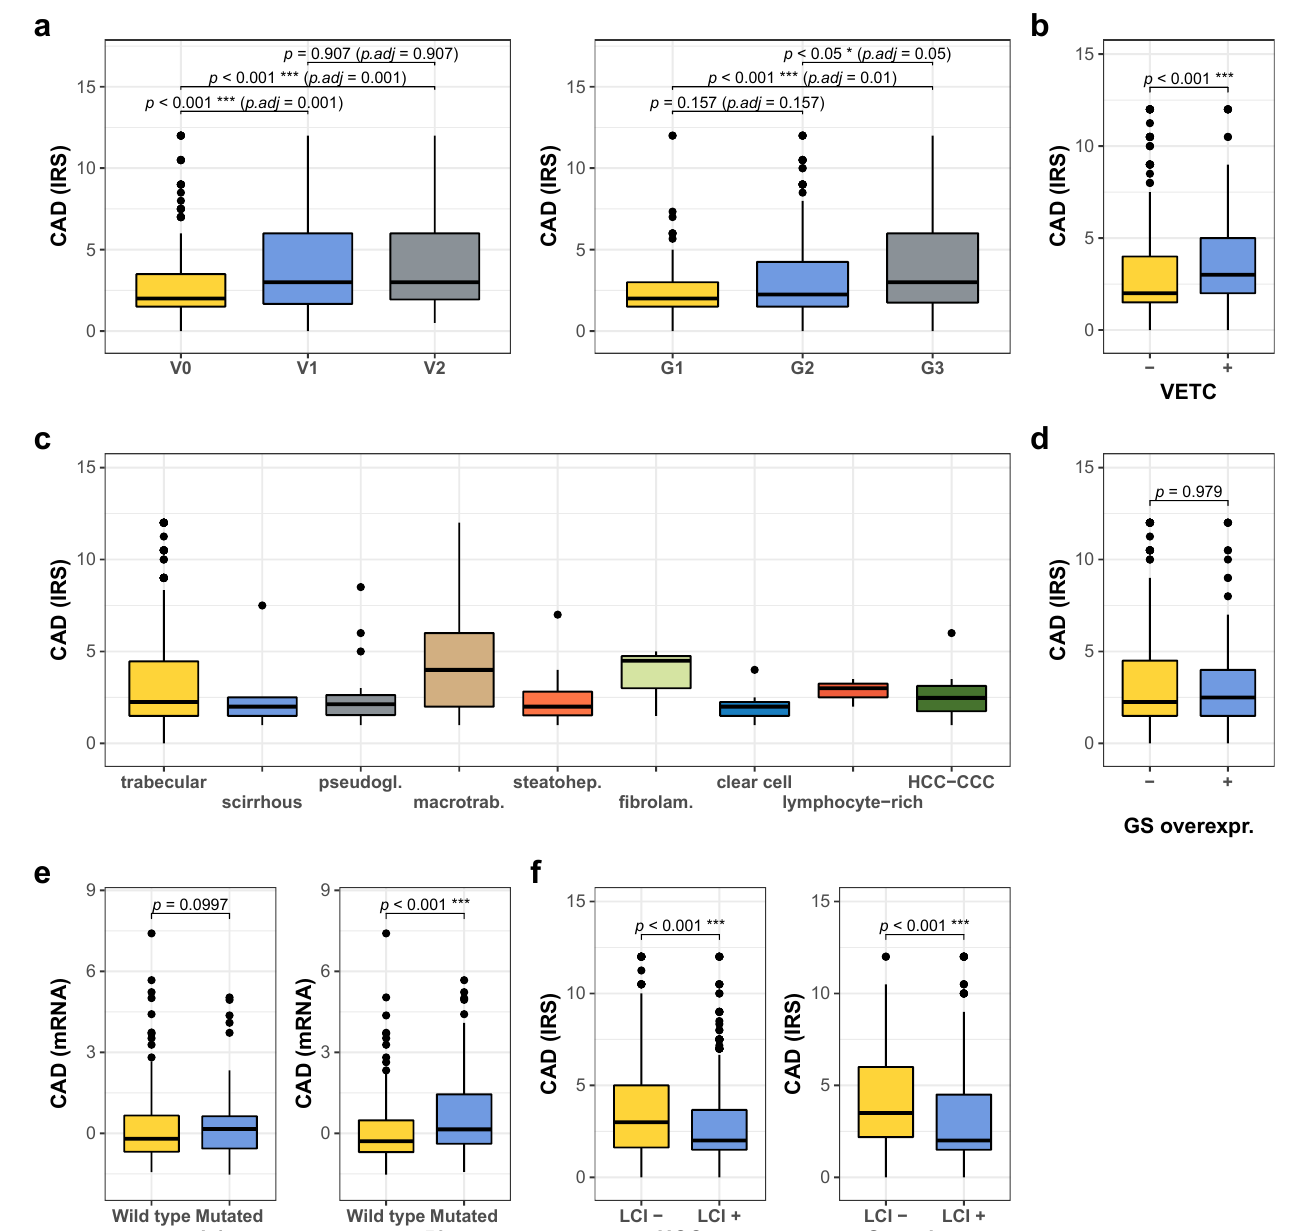
Figure 2. Comparison of CAD expression with clinicopathological and molecular parameters. ( a ) Quantification of CAD expression detected by immunohistochemistry with respect to vascular invasion (left panel, V0: n = 344, V1: n = 109, V2: n = 80) and tumor grade (right panel, G1: n = 99, G2: n = 265, G3: n = 115). ( b ) Quantification of CAD expression in relation to absence or presence of the VETC pattern (VETC-: n = 438, VETC+: n = 95). ( c ) Quantification of CAD expression according to morphological tumor subtype (patient numbers: trabecular: 418, scirrhous: 5, pseudogl.: 18, macrotrab.: 41, steatohep.: 22, fibrolam.: 3, clear cell: 7, lymphocyte-rich: 3, HCC-CCC: 8). ( d ) CAD expression levels in relation to absence or presence of GS overexpression as a marker for CTNNB1 mutations/activated WNT-signaling (GS neg.: n = 423, pos.: n = 109). ( e ) Quantification of CAD mRNA in the TCGA cohort with respect to mutational status of CTNNB1 (left panel, wild type: n = 264, mutated: n = 96) and TP53 (right panel, wildtype: n = 249, mutated 111). ( f ) Quantification of CAD expression in tumor tissue (left panel, no cirrhosis: n = 192, cirrhosis: n = 341) and in the surrounding liver tissue (right panel, no cirrhosis: n = 188, cirrhosis: n = 342) with respect to absence or presence of liver cirrhosis. For all analyses * denotes p ≤ 0.05, *** p ≤